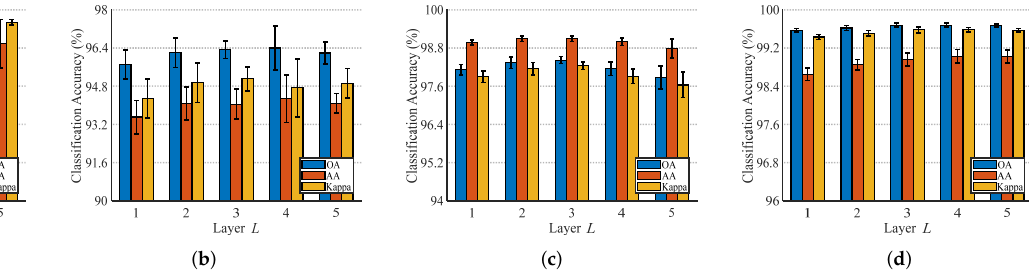
Figure 12. Effect of Inception Transformer’s layer L on the performance of IFormer network structures. ( a ) Indian Pines dataset. ( b ) Universit of Pavia dataset. ( c ) Salinas dataset. ( d ) Long Kou